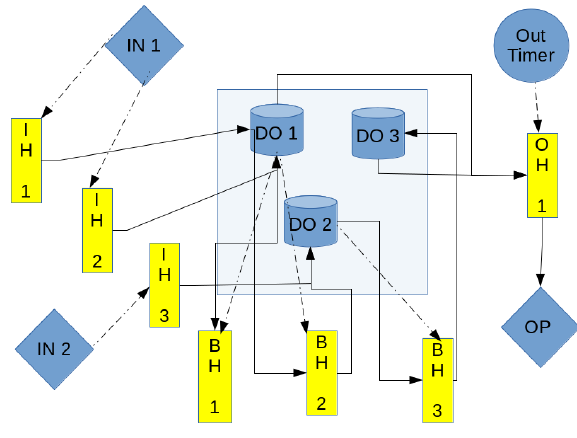
Figure 8. Taking advantage of Separation of Concerns